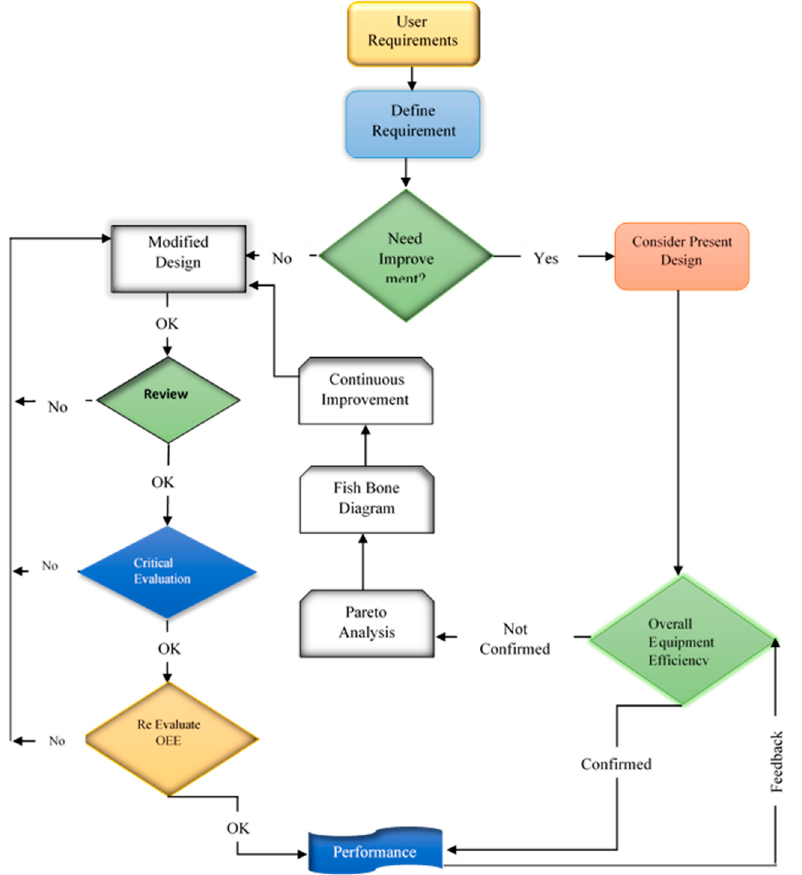
Figure 1. Flowchart of the research methodology plan used in this work.